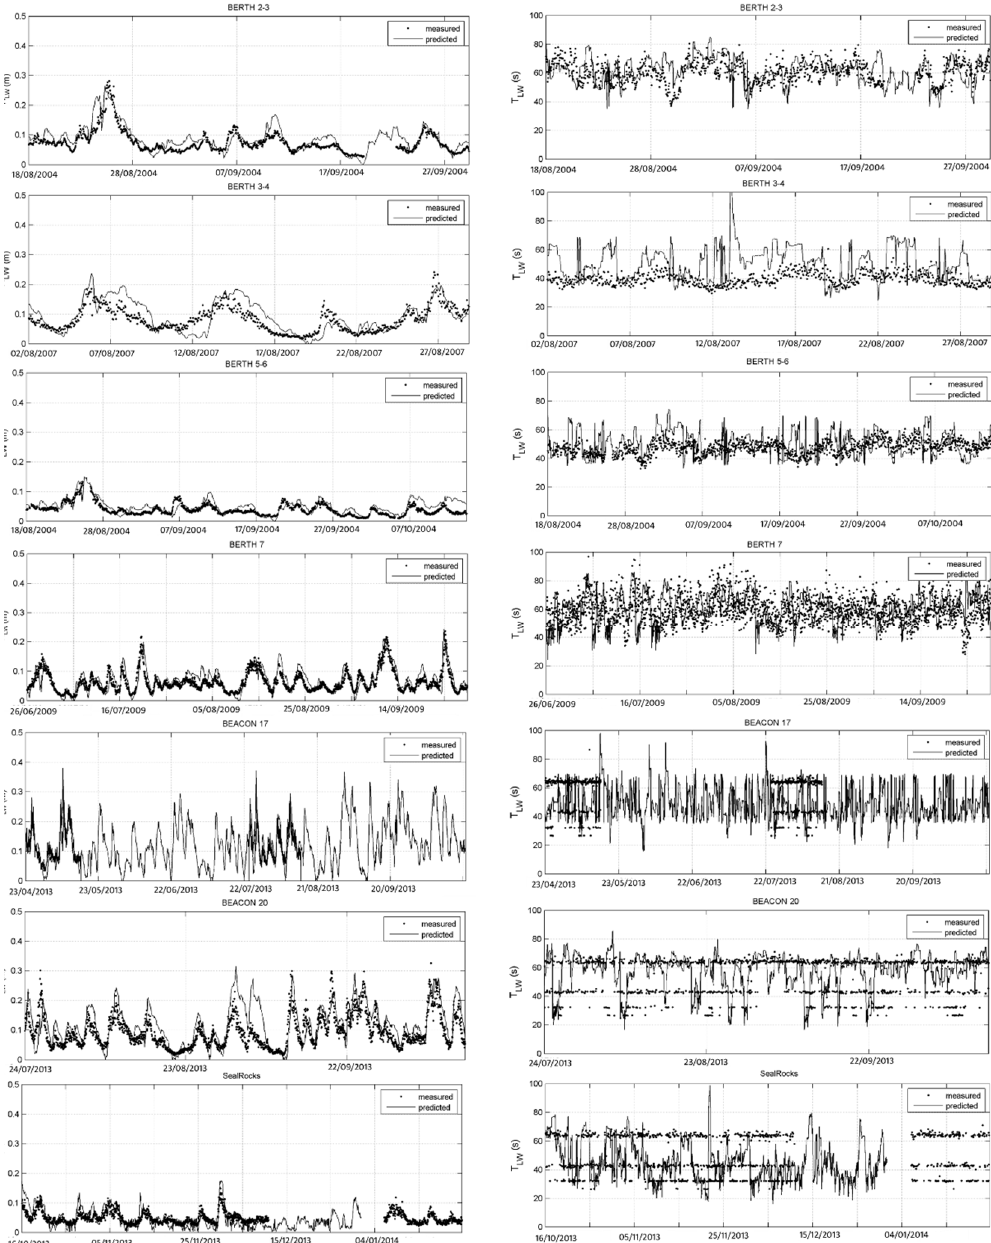
Figure 5. Comparison of long wave time series obtained for H LW and T LW for Berths 2 to 3, 3 to 4, 5 to 6 and 7, Beacons 17 and 20 and the Seal Rocks point. Predicted (line); measured (points).